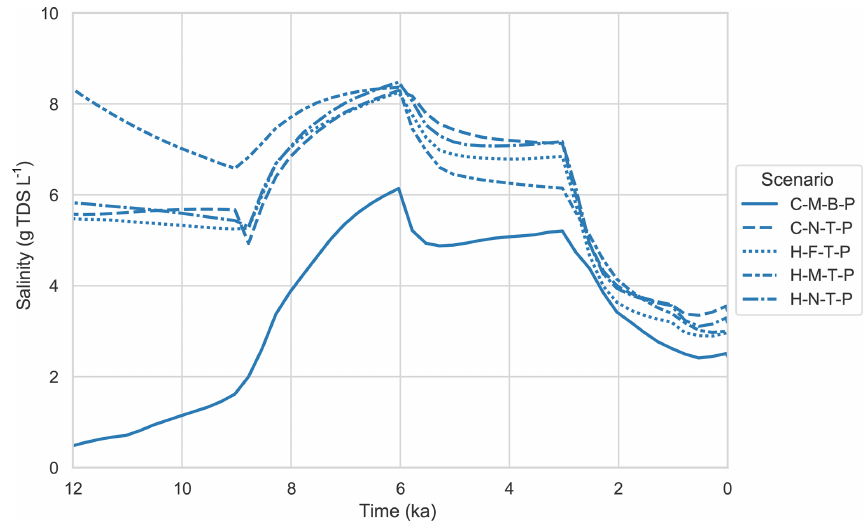
Figure A4. Mean modelled salinity during the Holocene. The dash type indicates the scenario. Salinities were sampled in the model domain at 40 locations where a freshening was observed in the field and